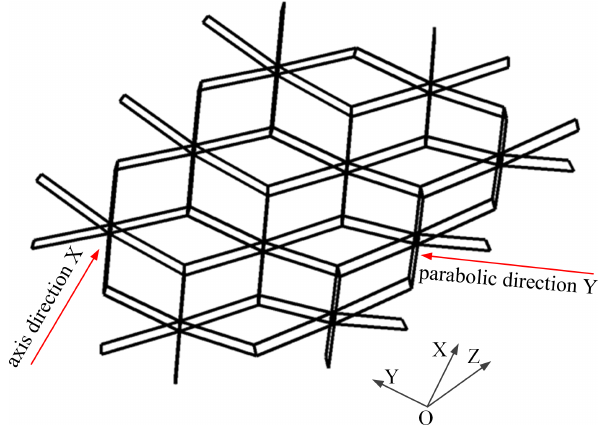
Figure 8. Geometry of a deployable mechanism composed of 10 hexagonal prism